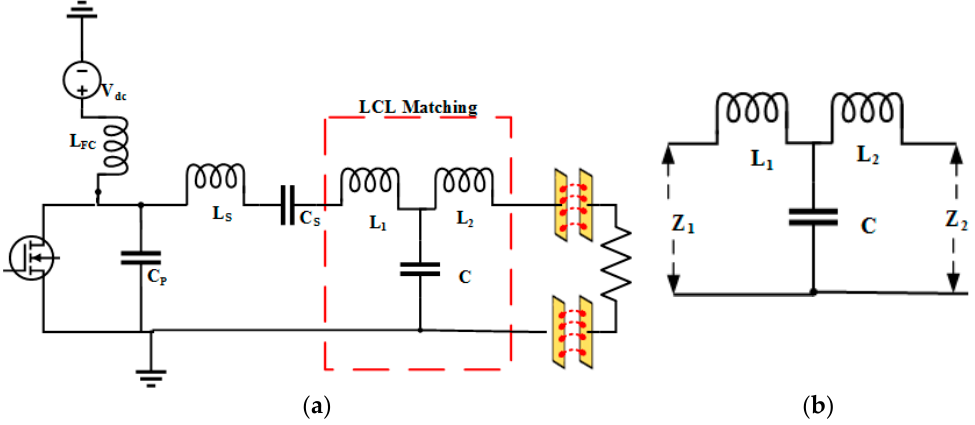
Figure 11. ( a ) Class E PA with LCL matching circuit; ( b ) T network model.